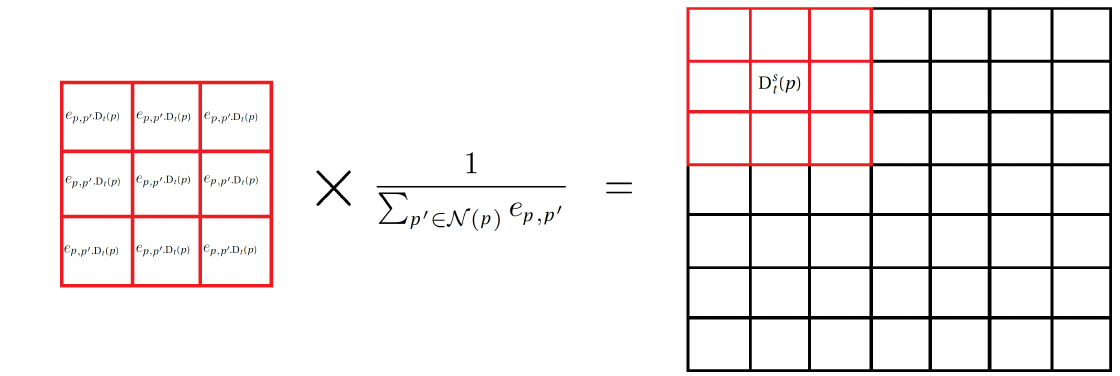
Figure 8. Spatial Fusion: aggregation of initial fuzzy decisions.